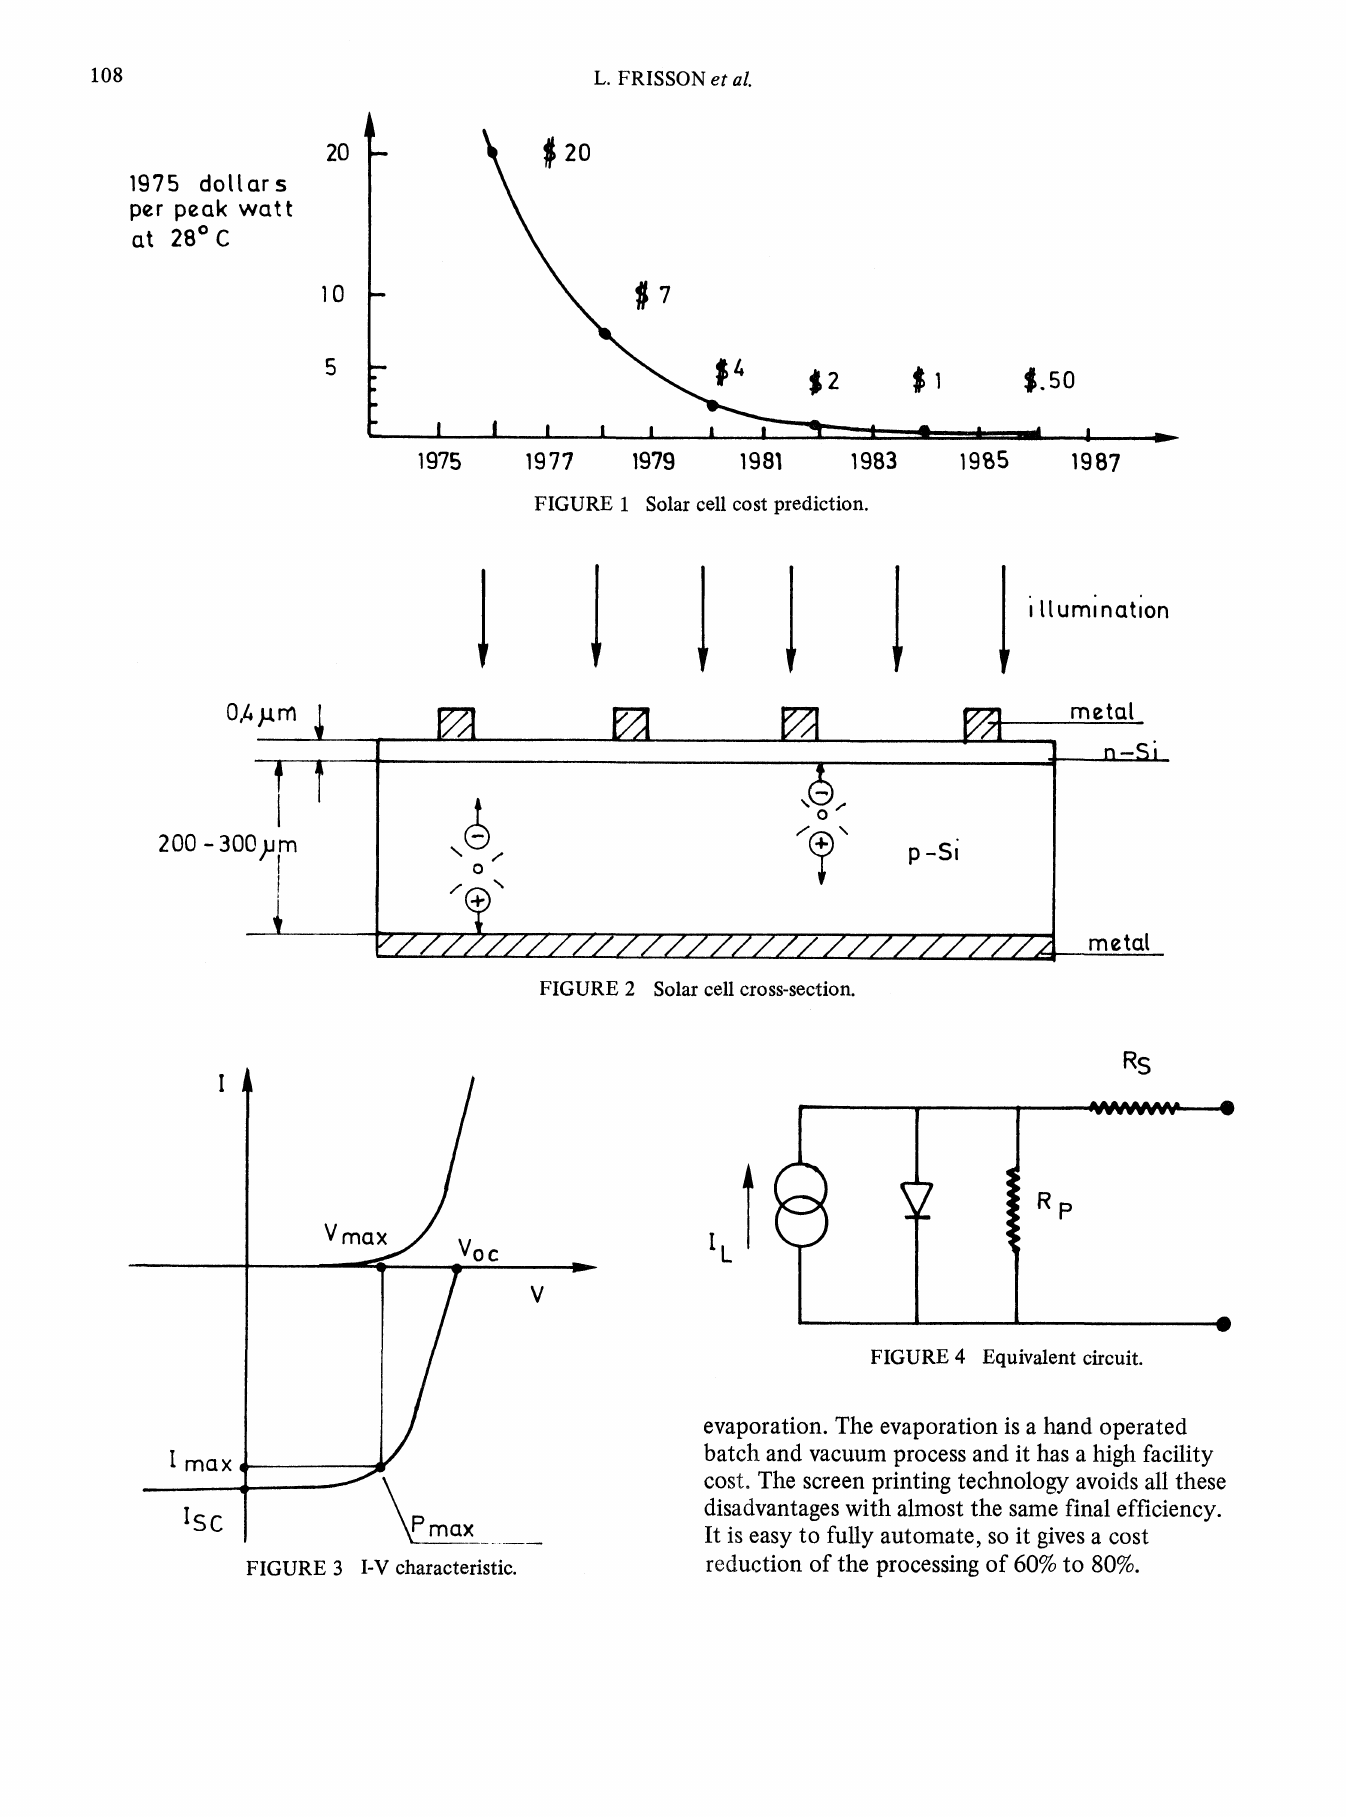
FIGURE Solar cell cost prediction.